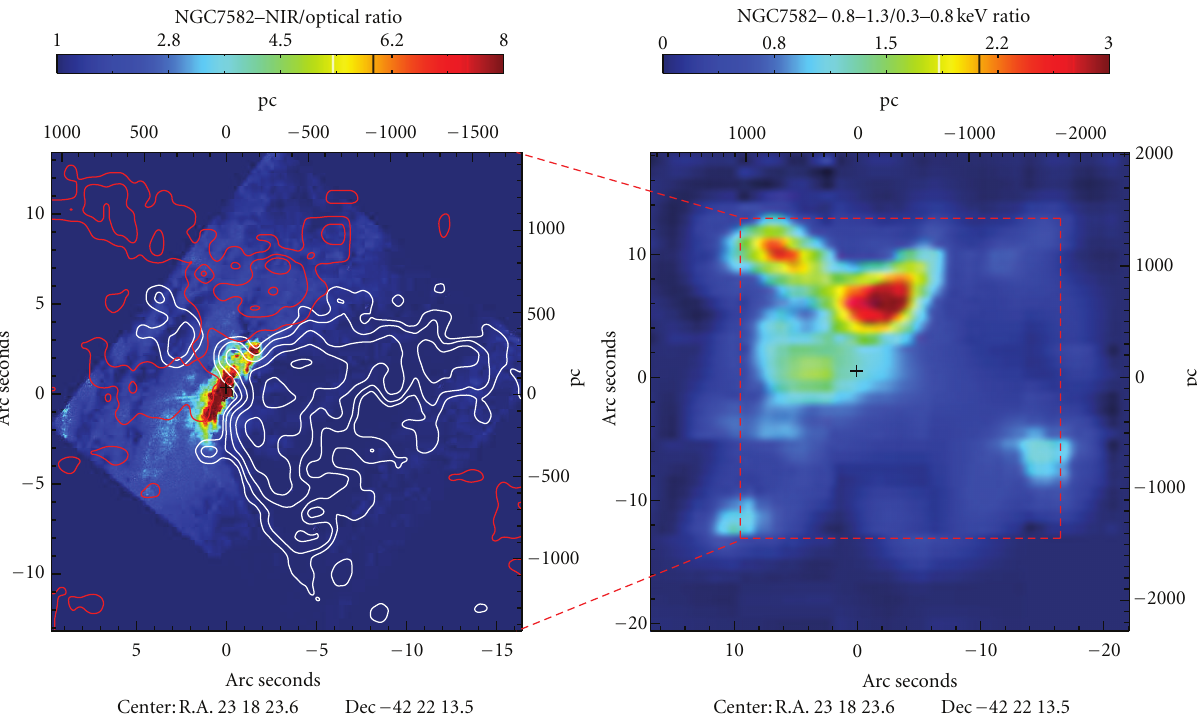
Figure 5: The Seyfert 2 galaxy NGC 7582 (from Bianchi et al. [95]). (a) HST NIR to optical ratio, mapping the amount of dust in the circumnuclear region of NGC 7582. The white contour plots refer to the Chandra emission below 0.8keV, while the red ones the ratio shown in the right panel. (b) Chandra 0.8–1.3 to 0.3–0.8 keV ratio. The red contour plots shown in left panel refer to this image, but the scale is di ff erent, as outlined by the broken-line rectangle. In both panels, the black cross indicates the position of the